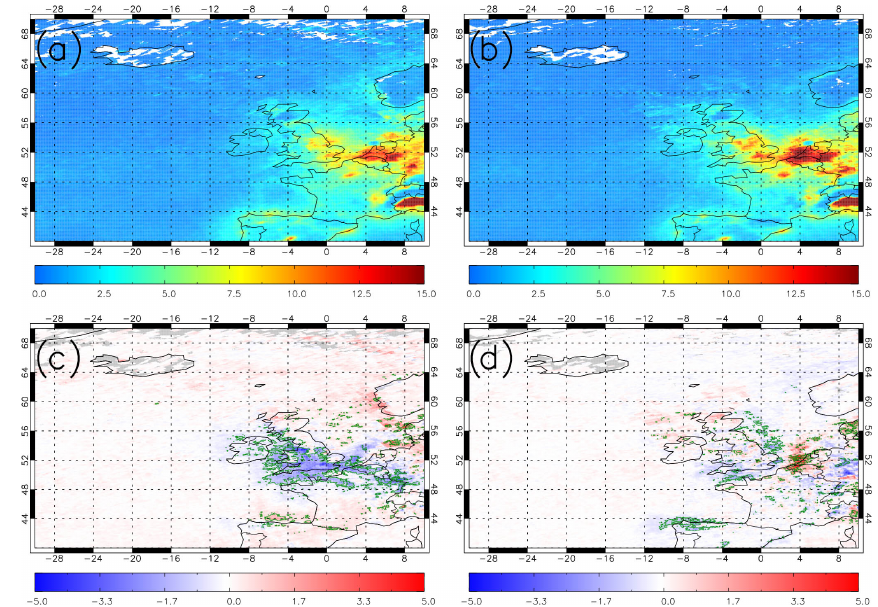
Figure 2. Mean Ozone Monitoring Instrument (OMI) tropospheric column NO 2 (10 15 moleculescm − 2 ) averaged between 2005 and 2015 under the wintertime (NDJF) NAOI. Panel (a) is column NO 2 sampled under the positive NAO phase, (b) is column NO 2 sampled under the negative NAO phase, (c) shows the column NO 2 positive NAO phase anomaly relative to the wintertime average and (d) is the column NO 2 negative NAO phase anomaly relative to the wintertime average. Green polygon-outlined regions highlight significant differences at the 95% confidence level based on the